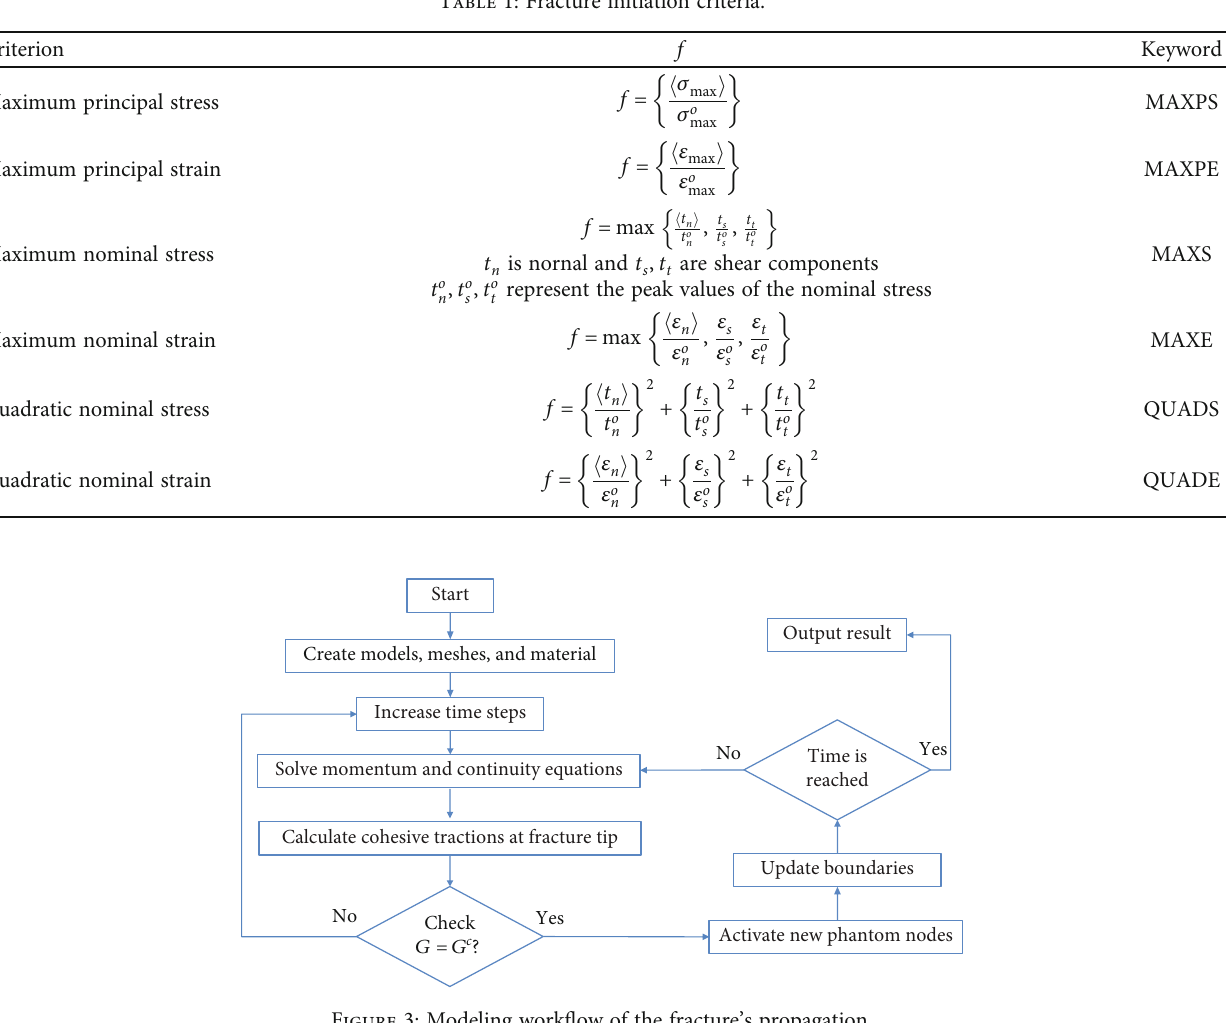
Table 1: Fracture initiation criteria.